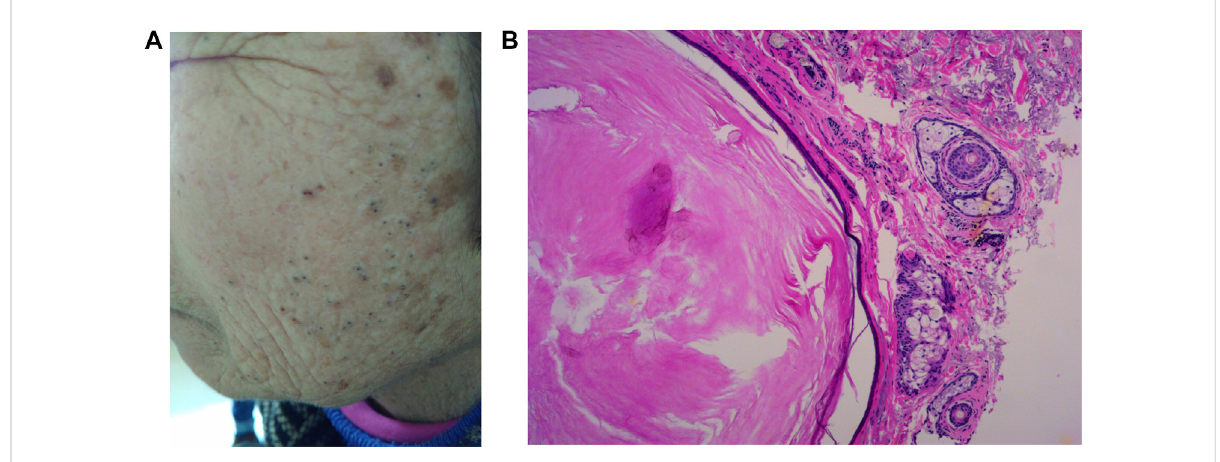
FIGURE 2 Favre – Racouchot disease (FRD) manifests as cutaneous atrophy and elastosis with keratinization of the pilosebaceous follicle and comedone formation and mainly affects the skin which is greatly exposed to sunlight (A) . Histology shows atrophic and keratinized SGs (B)